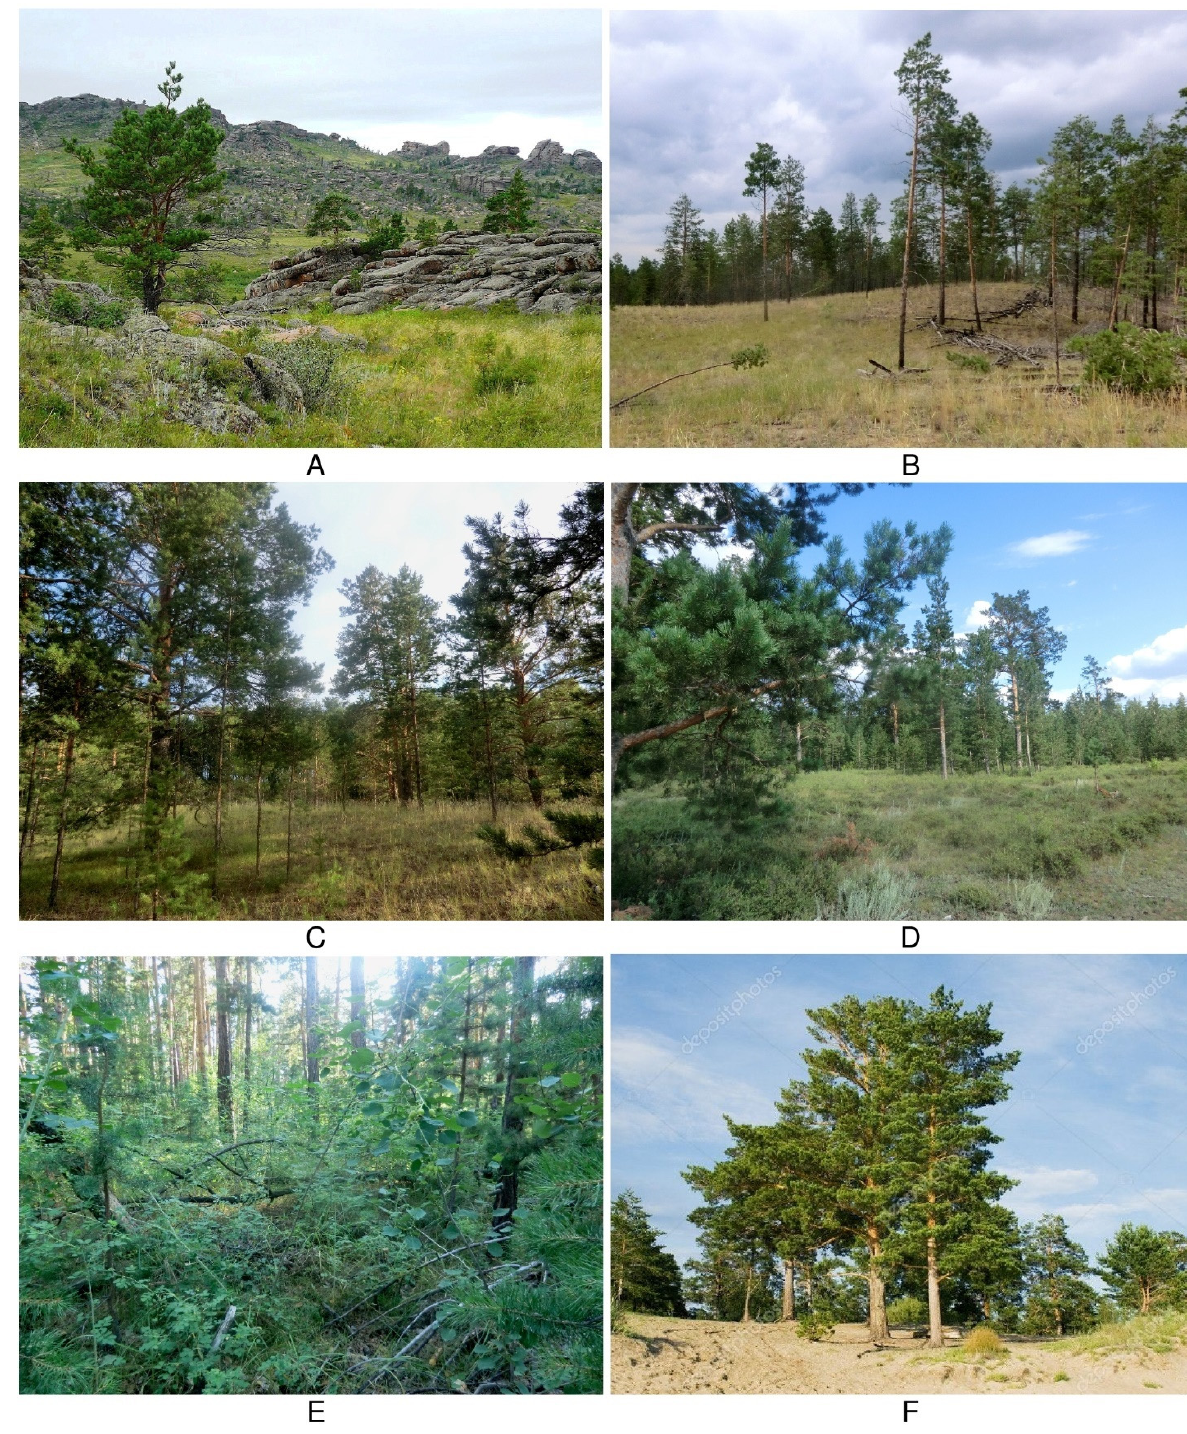
Figure 4. Diversity of the pine forest cover at the Bayanaul NP ( A ), the Beskaragai ( B , C ) and the Chaldai ( D – F ) NR sites in respect to geomorphic setting. At both sites, the relief predetermines the particular parkland pine forest type showing the tree stands’ density increase, the pine forest regeneration enhance and an overall positive forest vitality trend as a function of rising annual precipitation and ground-water availability. ( A ) Mountain forest (Bayanaul NP); ( B ) dry forest hill (TP 1); ( C ) upland plateau forest (TP 3); ( D ) semi-arid plain forest (TP 5); ( E ) semi-humid flat plain forest (TP 3); ( F ) sandy plain forest on sandy dunes above the Irtysh River floodplain. Photographs by the